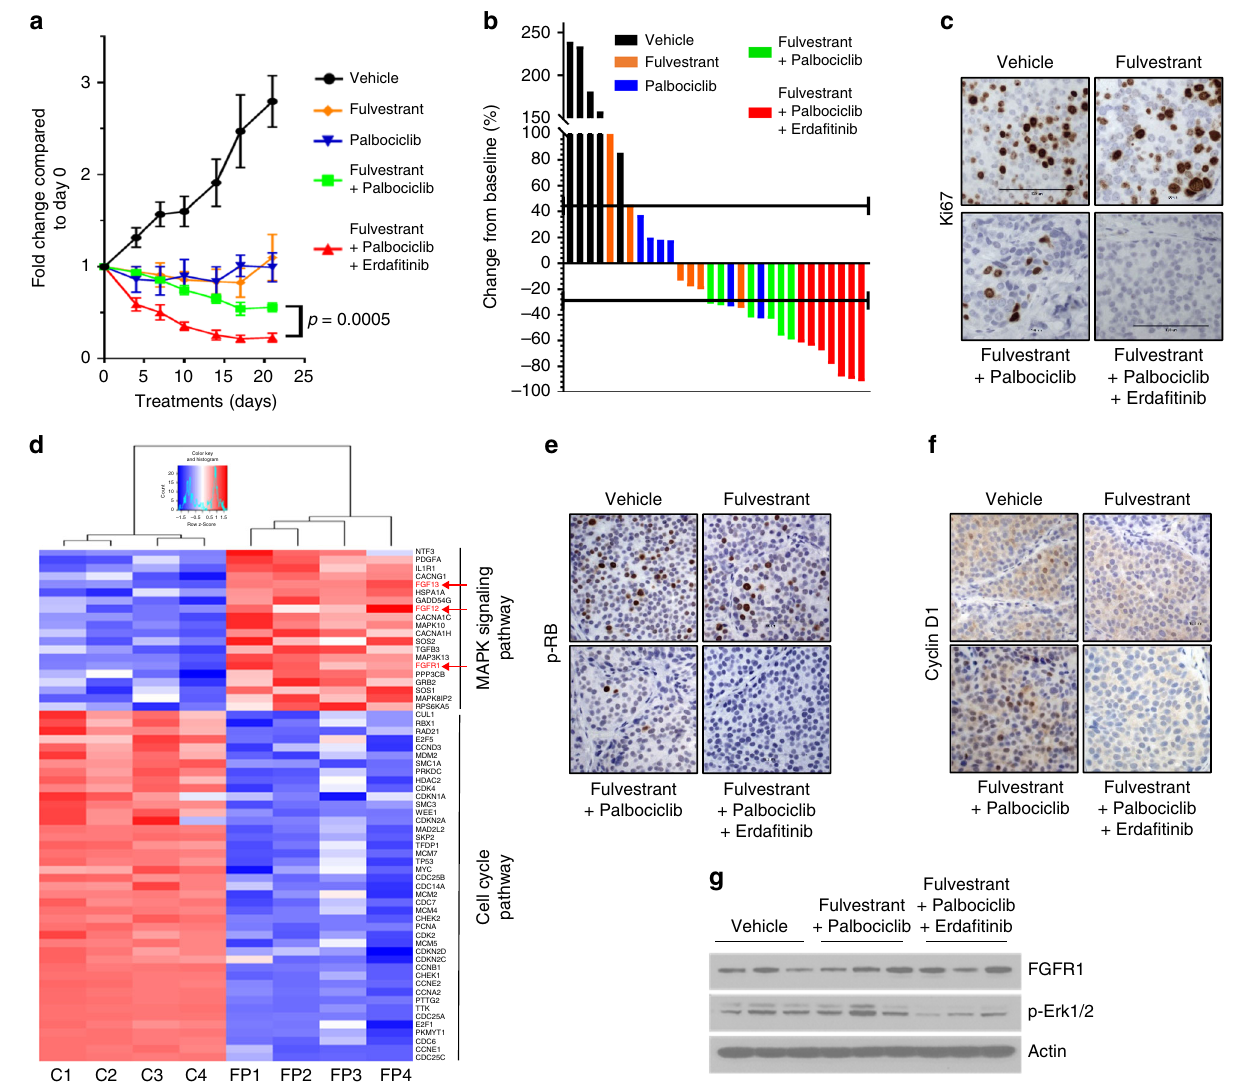
Fig. 6 Combined inhibition of ER, CDK4/6, and FGFR1 inhibits the growth of ER α / FGFR1 -ampli fi ed breast cancer PDXs. a ER + /HER2 − / FGFR1 -ampli fi ed TM00386 PDX fragments were established in ovariectomized SCID/beige mice supplemented with a 21-day release, 0.25-mg 17 β -estradiol pellet. Once tumors reached ≥ 200 mm 3 , mice were randomized to the indicated treatment arms. Each data point represents the fold change in volume ± SEM ( n = 8 per arm; ANOVA test). b Bar graph showing the % change in volume in individual xenografts after 3 weeks of treatment relative to individual tumor volumes on day 0. c Xenografts were harvested after 1 week of treatment and FFPE tumor sections were subjected to Ki67 IHC as described in Methods. The percent of Ki67 + tumor cells (inset) was assessed by an expert breast pathologist (P.G.E.) blinded to the treatment arm. d TM00386 PDXs in mice treated with vehicle or fulvestrant plus palbociclib were harvested and snap frozen at the end of treatment. RNA was extracted and subjected to nanoString analysis as described in Methods. Heat map represents different gene expression levels between controls ( n = 4) and tumors treated with fulvestrant plus palbociclib ( n = 4). e , f TM00386 PDXs were harvested at the end of treatment. FFPE sections from the PDXs were subjected to IHC with p-RB ( e ) and CCND1 ( f ) antibodies as described in Methods. The percent of p-RB and CCND1-positive tumor cells and their staining intensity were assessed by an expert breast pathologist (P.G.E.) blinded to the treatment arm to generate an H -score (shown in Supplementary fi gures). g TM00386 tumors were harvested at the end of treatment, 4 h after the last dose of palbociclib and erda fi tinib and 24 h after the last dose of fulvestrant. Tumor lysates